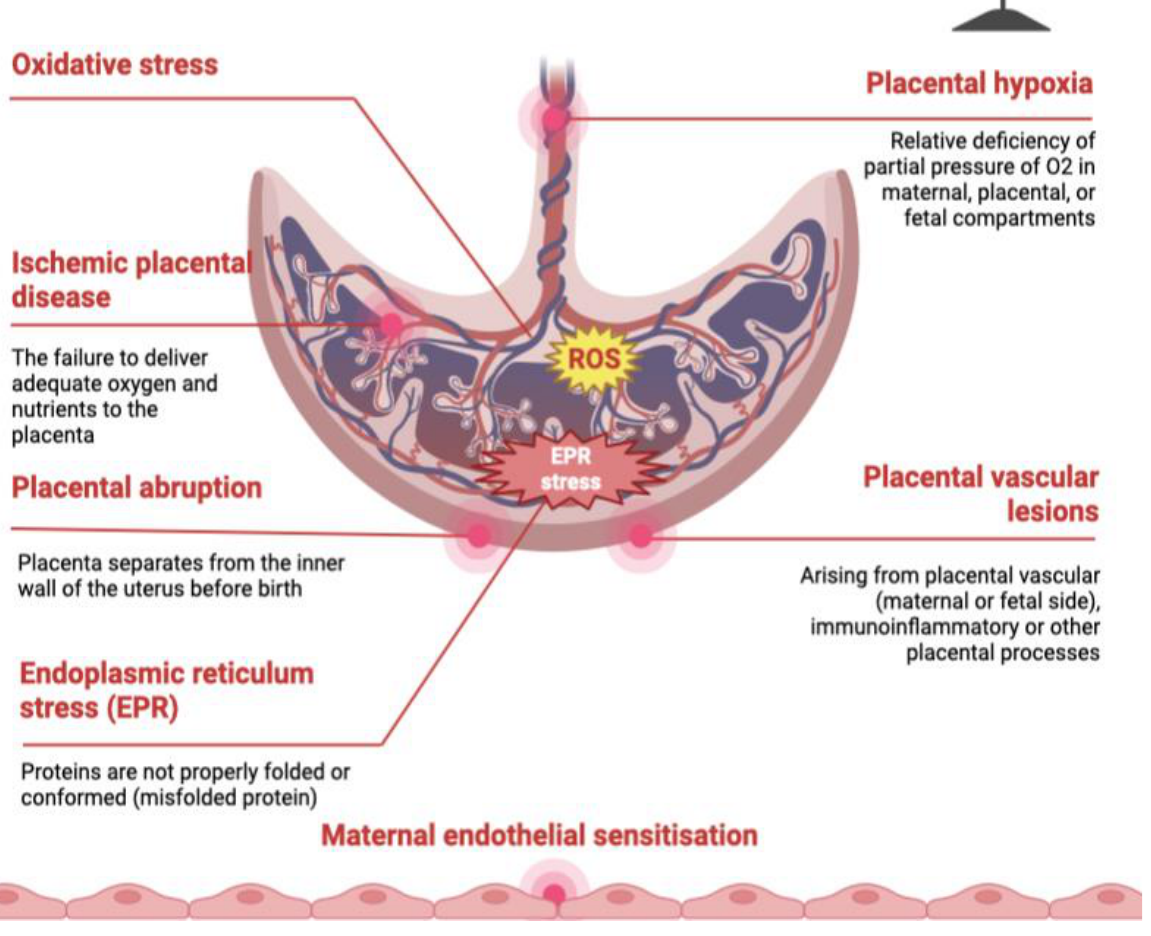
Figure 1. The figure summarizes the various pathological changes typical of pre-eclampsia, which are associated with an increasing sFlt1/PlGF ratio.